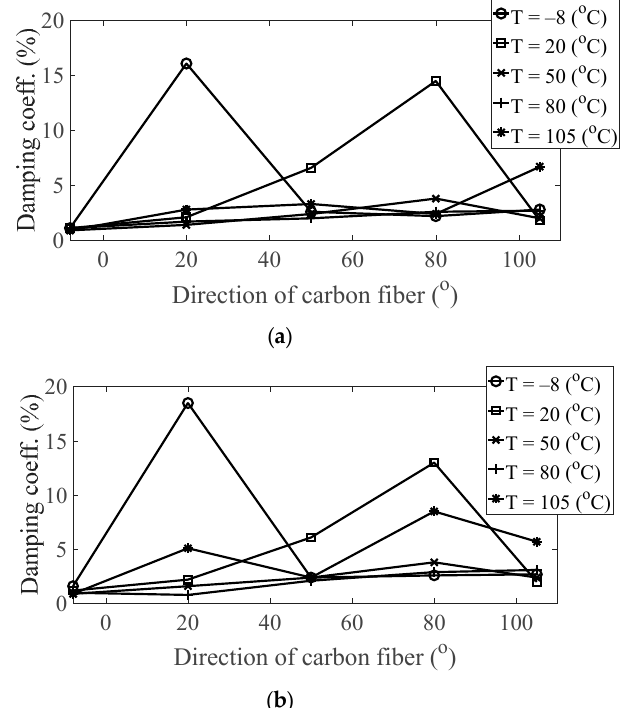
Figure 13. Variation of damping coefficient ( ξ 1 ) according to different directions of carbon fiber: ( a ) p = harmonic and ( b ) p = random.